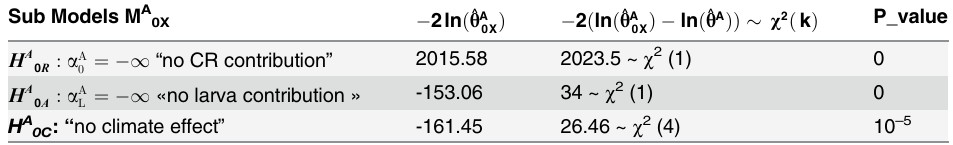
Table 3. Adult presence: hypothesis testing on covariate